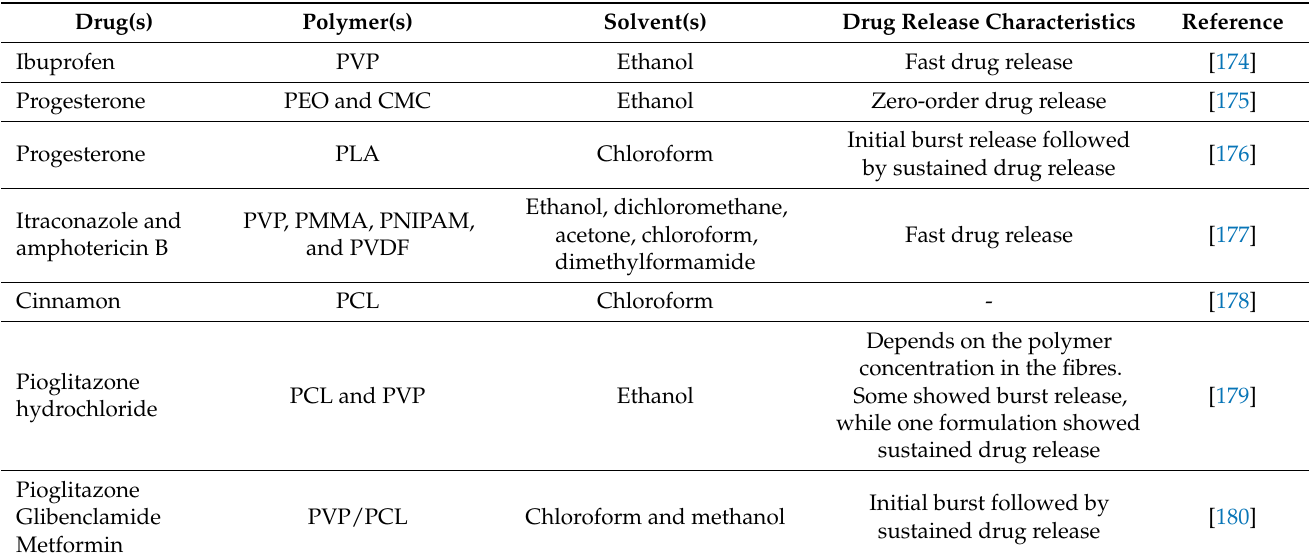
Table 11. Studies in which pressurised gyration has been employed for drug delivery applications.